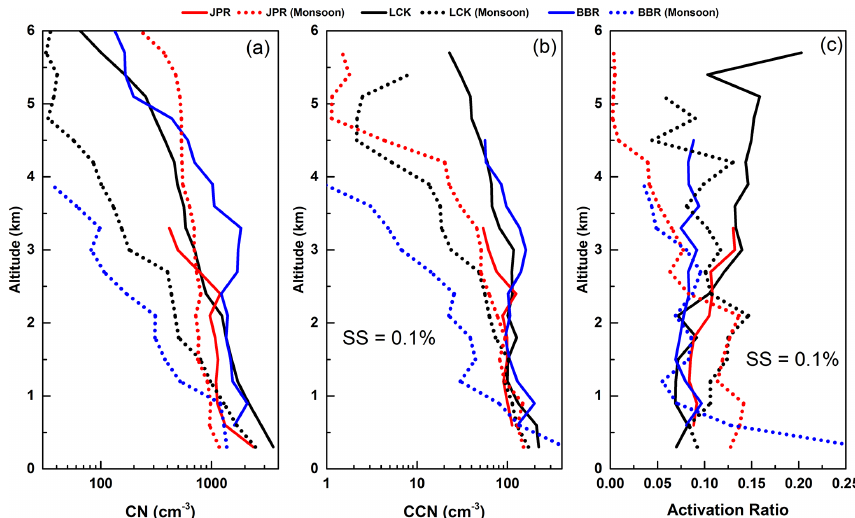
Figure 7. The changes in the altitude variations of (a) CN concentrations, (b) CCN concentrations and (c) activation ratios during the SWAAMI campaign. The solid lines represent the values during Phase 1 and the dotted lines show the values during Phase 3.